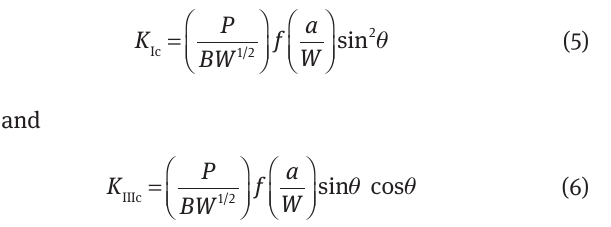
Figure 4: Load-displacement curves for un-notched specimens at particle content of 5 and 20